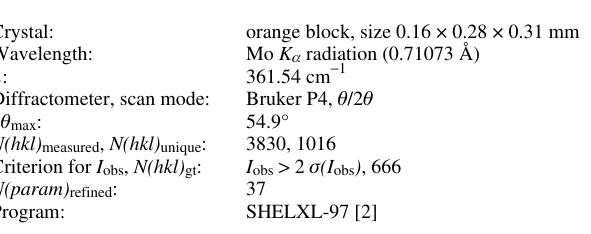
Table 1. Data collection and